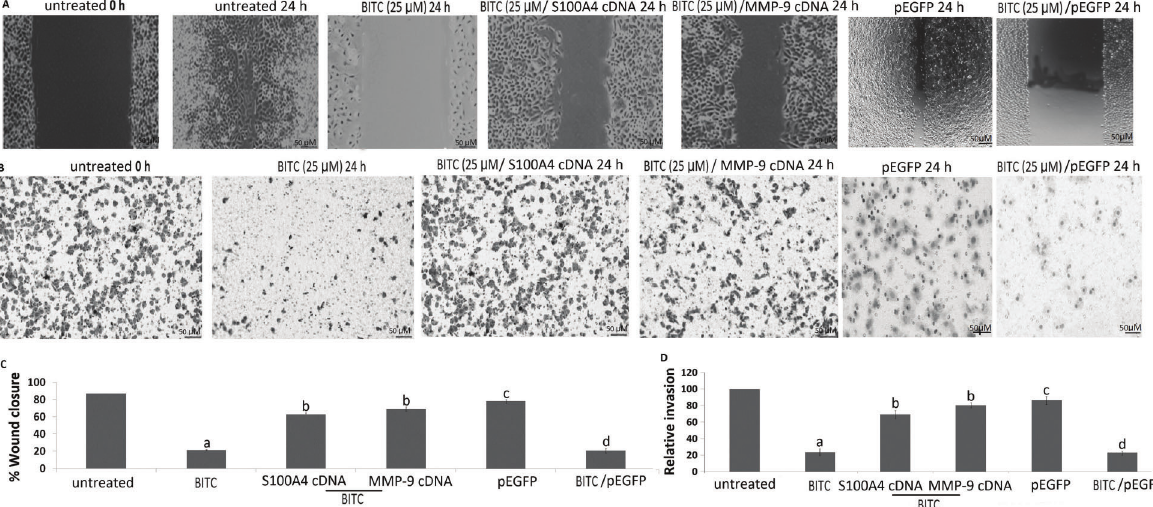
Figure 2. Benzyl isothiocyanate (BITC) inhibits invasion and migration of SCC9 cells via S100A4/MMP-9 signals. A, Representative photomicrographs of wound healing assay in SCC9 cells after treatment of 25 m M BITC or transfected with S100A4 cDNA/MMP-9 cDNA for 24 h. B , SCC9 cells were treated with 25 m M BITC or transfected with S100A4 cDNA/MMP-9 cDNA for 24 h. Cells that migrated to the bottom chamber containing serum-supplemented medium were stained with 0.1% crystal violet, visualized under a phase-contrast microscope, and photographed. C , Statistical analysis of wound healing assay; D , Statistical analysis of the invasive cells. Data are reported as means ± SE. a P o 0.05 vs untreated; b P o 0.05 vs BITC; c P 4 0.05 vs untreated; d P 4 0.05 vs BITC (Student ’ s t